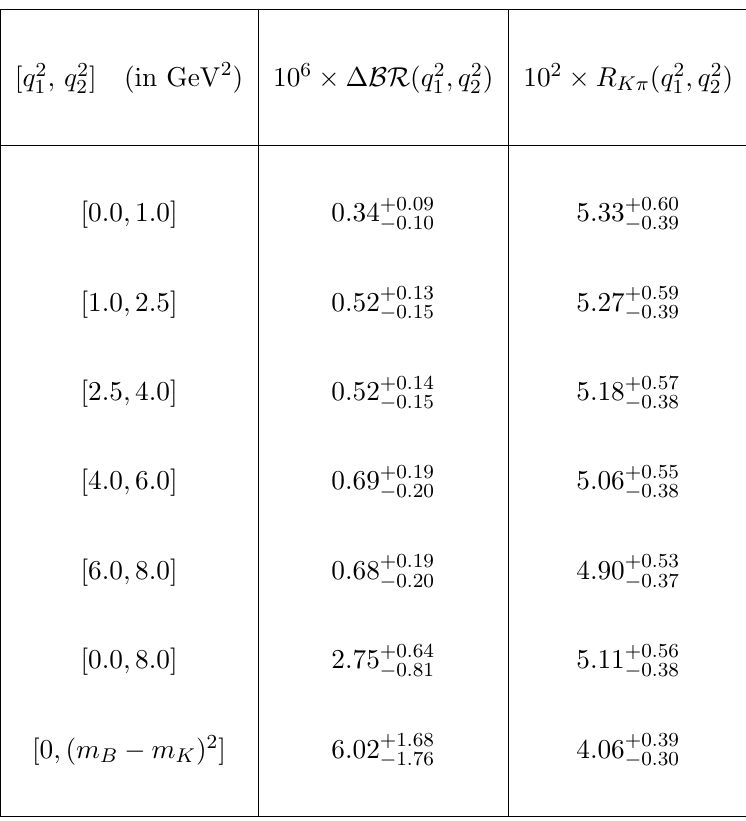
; q 2 ) with B ! (cid:25); K form factors computed from 1 2